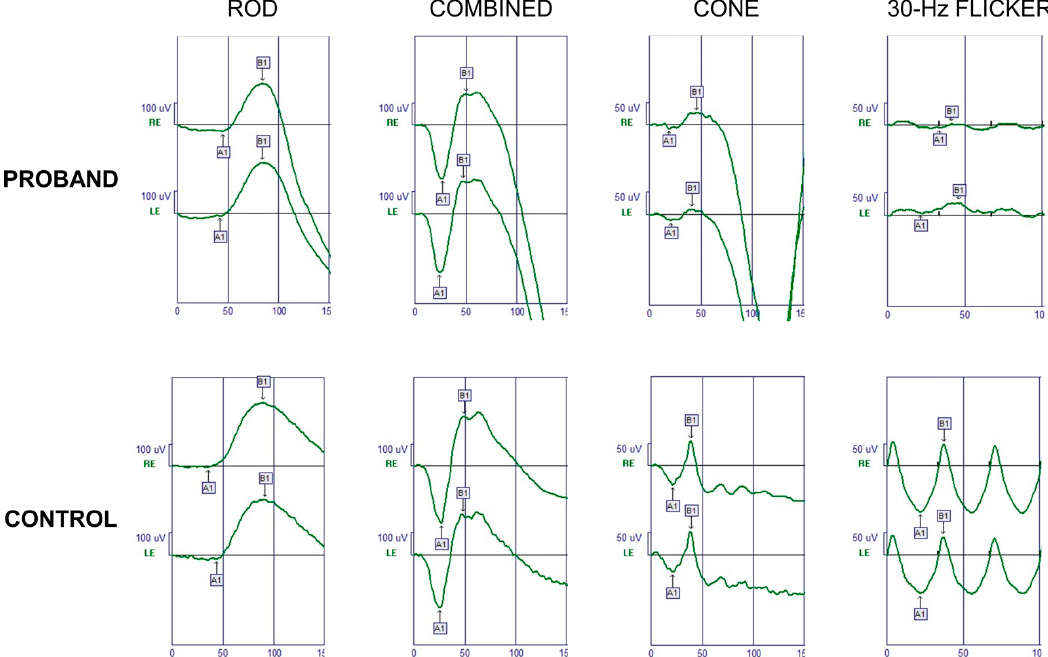
Figure 3. Full-field ERG of the proband’s right eye (RE) and left eye (LE). Normal responses are provided for comparison (Control). After a 30-min dark adaptation, dark-adapted responses (Rod and Combined) were within normal limits, while photopic components were reduced (Cone and 30-Hz flicker).